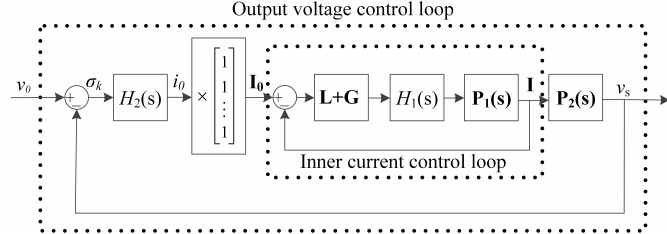
Figure 4. The closed-loop model of the multi-module charging